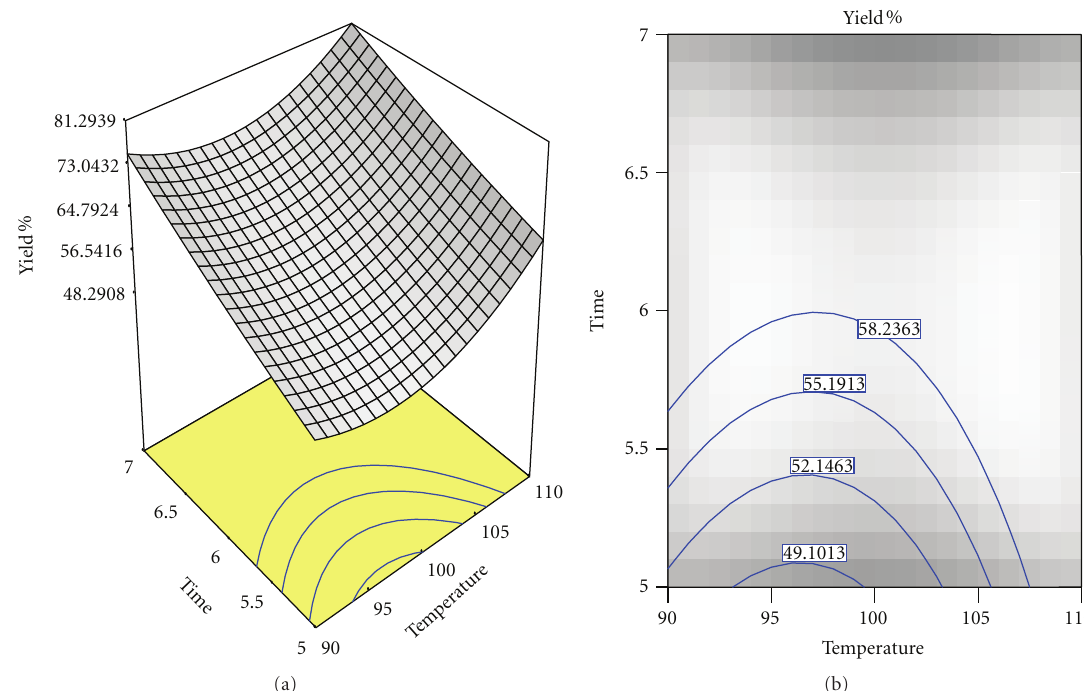
Figure 2: Response surface (a) and contour plots (b) for the e ff ect of reaction temperature ( X 3 , ◦ C) and reaction time ( X 4 , h) on the yield ( Y , %) of OLHYOOD. Table 5: The main wavelengths in FTIR functional groups of HYOOA and OLHYOOD. Wavelength of HYOOA a Functional